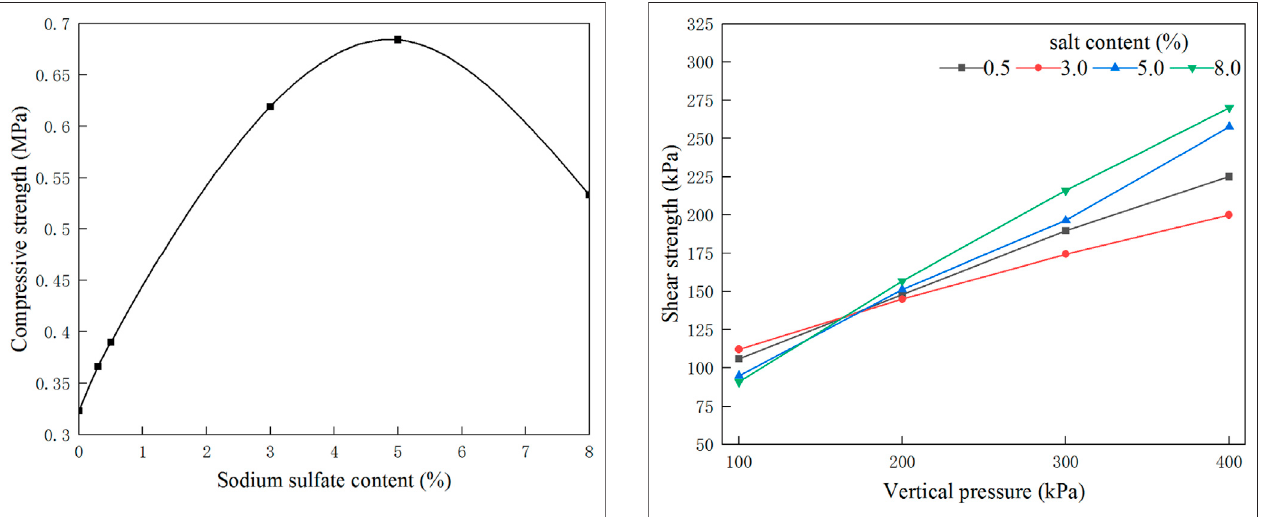
FIGURE 6 | Relationship between vertical pressure and shear strength of sulfate saline soil with different sulfate